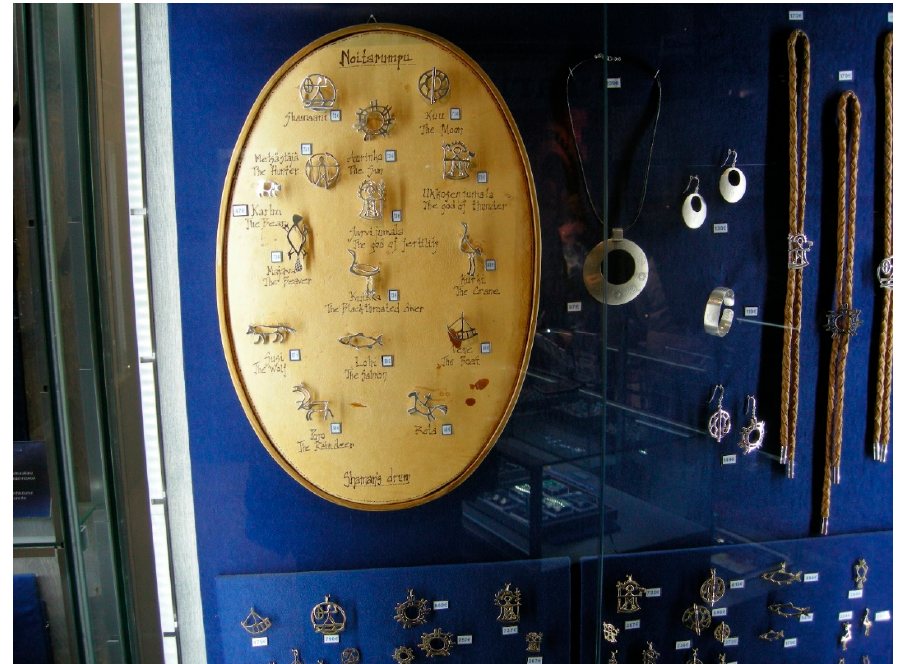
Figure 3. Silver figures, freely based on what allegedly are motifs from Sámi Noaidis’ divination drums. From Taigakoru’s souvenir shop in Santa Claus Theme Park in Roavvenárga/Rovaniemi, Finland June 2019. Photo by the author. The silver patterns associated with the signs on the Noaidi’s drum and represented in this collection are the sun, the bear, the black-throated loon, the crane, the moon, the salmon, the beaver, the god of hunting, the lights of the north, the reindeer, the rota 7 , the goddess of fertility Akka, the shaman, the wolf, the god of thunder, and the boat (ibid.; see also on the Taigakoru (n.d.) jewelry, with image, in Ridanpää (2019, p. 130f)). Notable here is that the symbols from the drum skin are explicitly associated with a more general reference to a sub-Arctic, Fenno-Ugric cultural environment, possibly to avoid questions of cultural ownership.